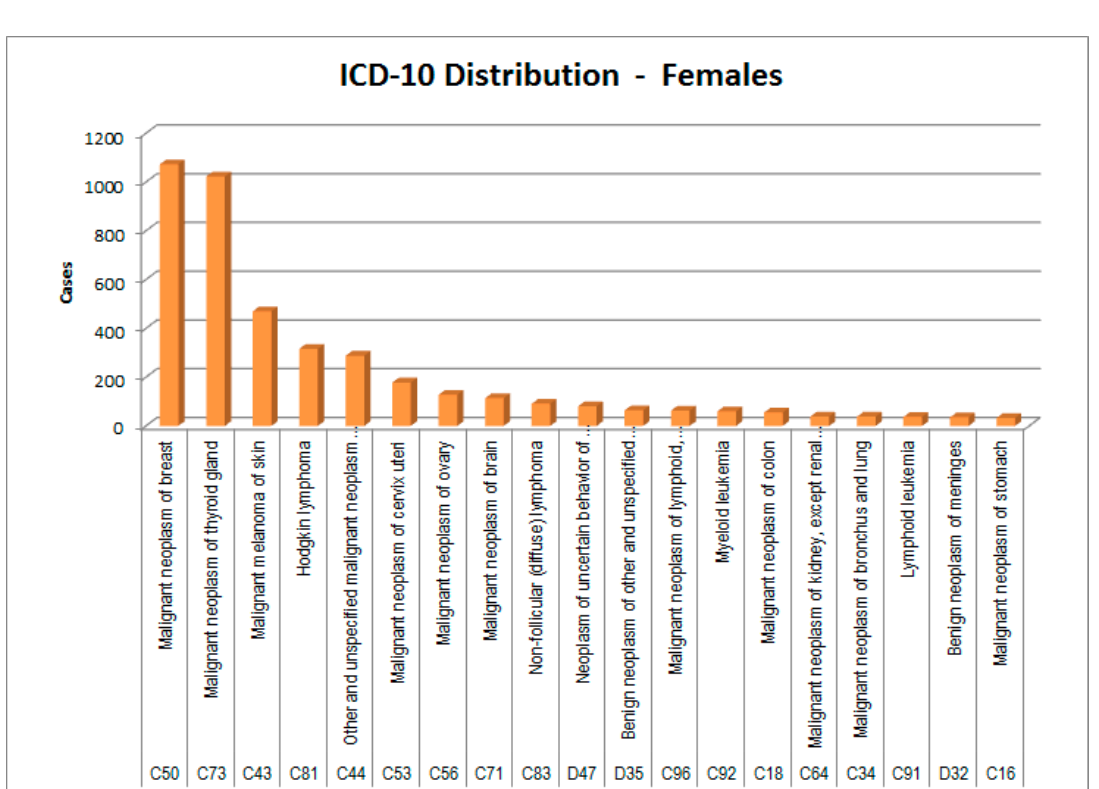
Figure 5. ICD ‐ 10 distribution of cases—females.